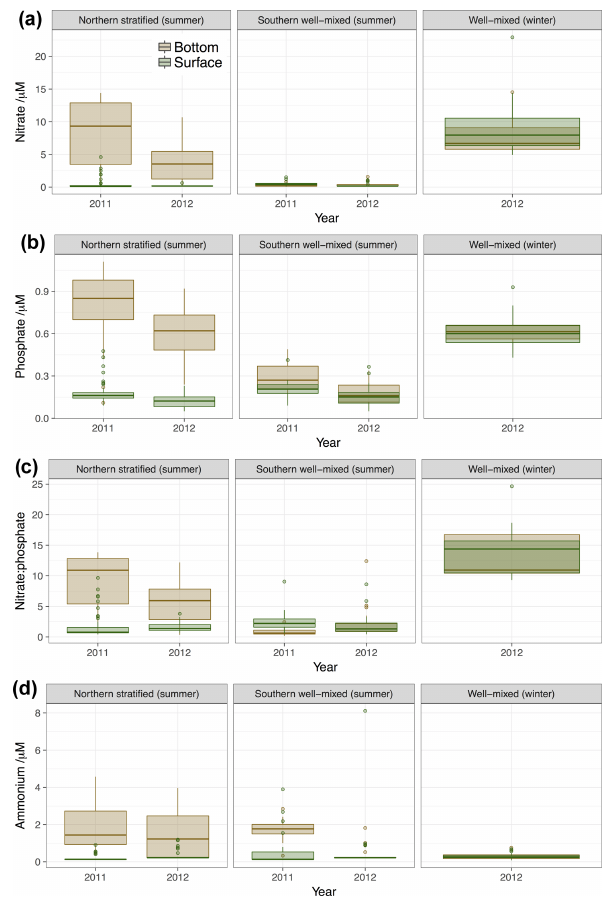
Figure 4. Summary of inorganic nutrient observations demonstrat- ing the differences between surface and bottom samples, different mixing regimes, seasons and years. (a) nitrate, (b) phosphate, (c) ni- trate to phosphate ratio and (d) ammonium concentration. Box and whisker plots show statistical summary of the data where the thick horizonal like represents the median value, the extent of the boxes represents the interquartile range and whiskers represent the full range of data up to 1.5 interquartile distances from the median. Any points outside this range are shown as discrete